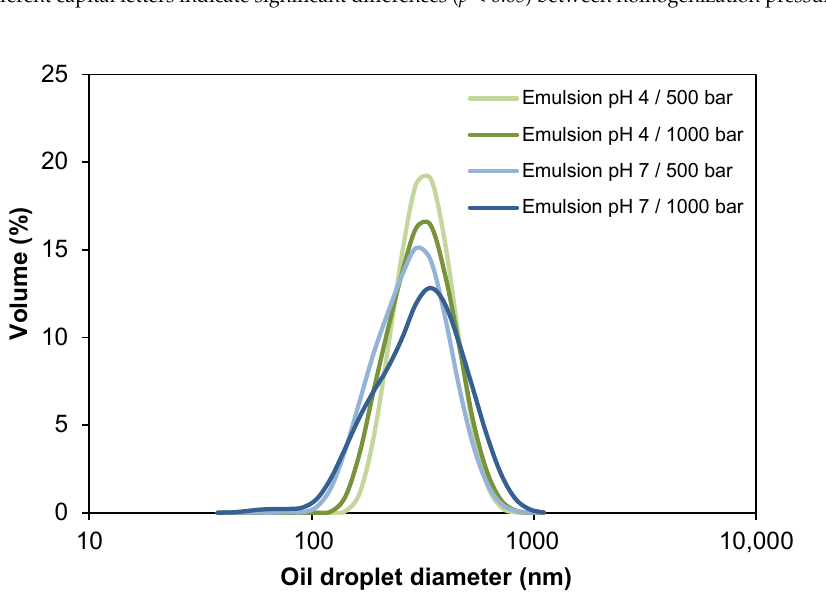
Different lowercase letters indicate significant differences ( p < 0.05) between pH of the O/W emulsions, and different cap- ital letters indicate significant differences ( p < 0.05) between homogenization pressures.